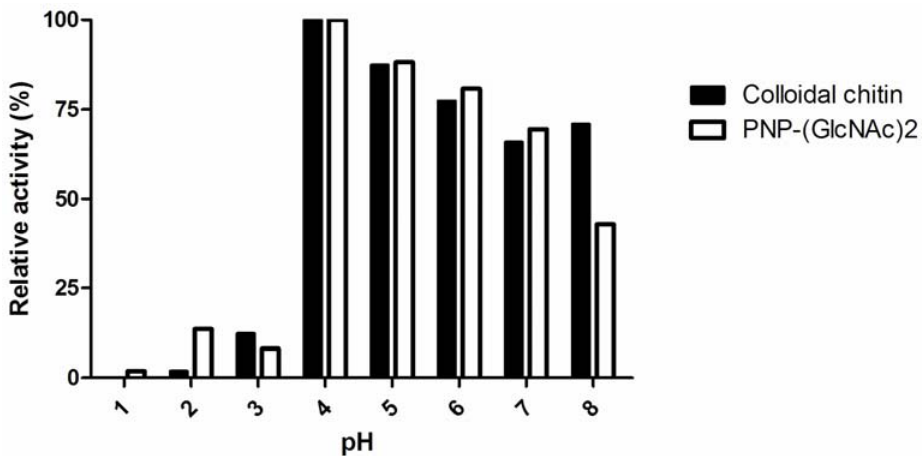
Figure 3. The effect of pH on the chitinase and chitotriosidase activities of